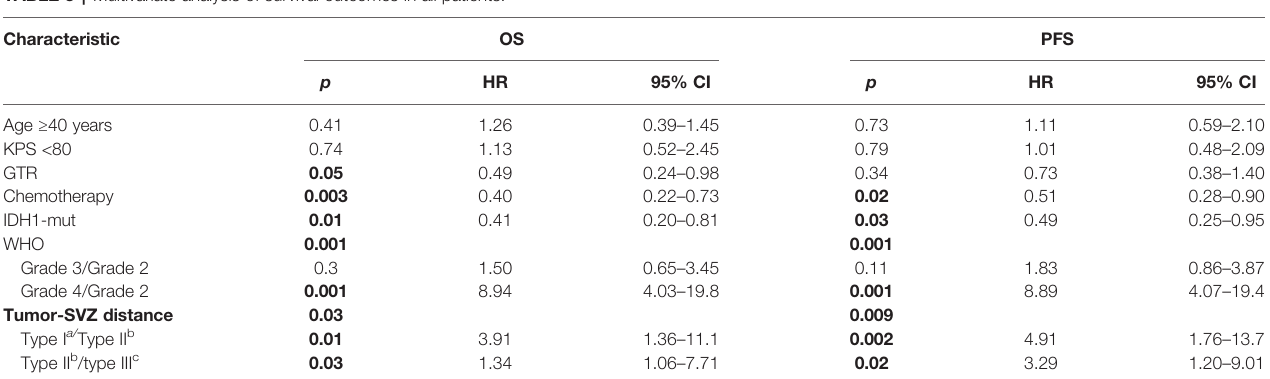
TABLE 3 | Multivariate analysis of survival outcomes in all patients. Characteristic